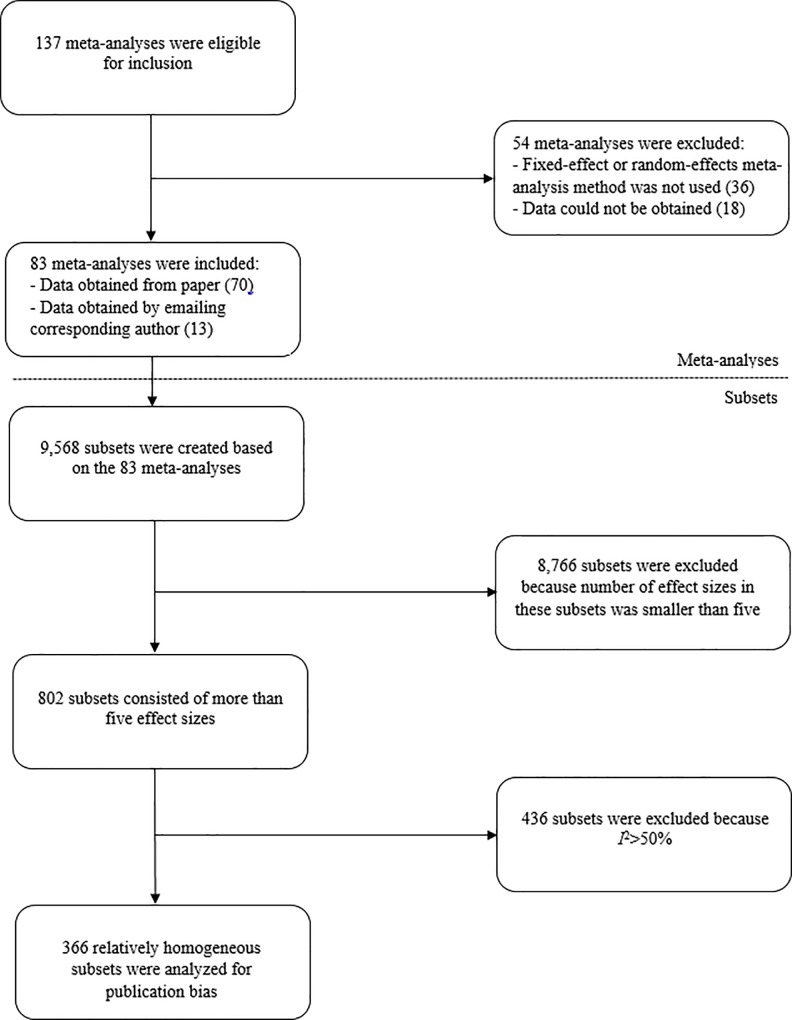
Flowchart illustrating the extraction procedure of data from meta-analyses published in Psychological Bulletin between 2004 and 2014.